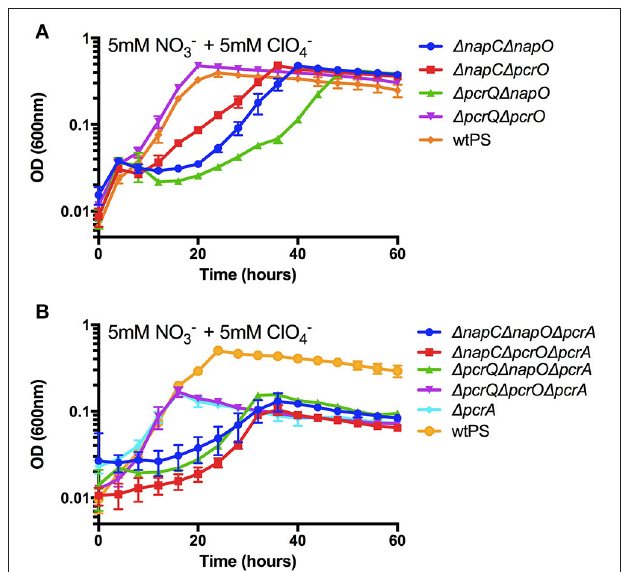
FIGURE 4 | Growth of wtPS, ∆ napC ∆ napO , ∆ napC ∆ pcrO , ∆ pcrQ ∆ napO , and ∆ pcrQ ∆ pcrO (A) , and ∆ pcrA, ∆ pcrA ∆ napC ∆ napO , ∆ pcr ∆ napC ∆ pcrO , ∆ pcrA ∆ pcrQ ∆ napO , and ∆ pcrA ∆ pcrQ ∆ pcrO (B) on LMM medium with 5mM nitrate and 5mM perchlorate. Error bars represent standard deviations of biological triplicate